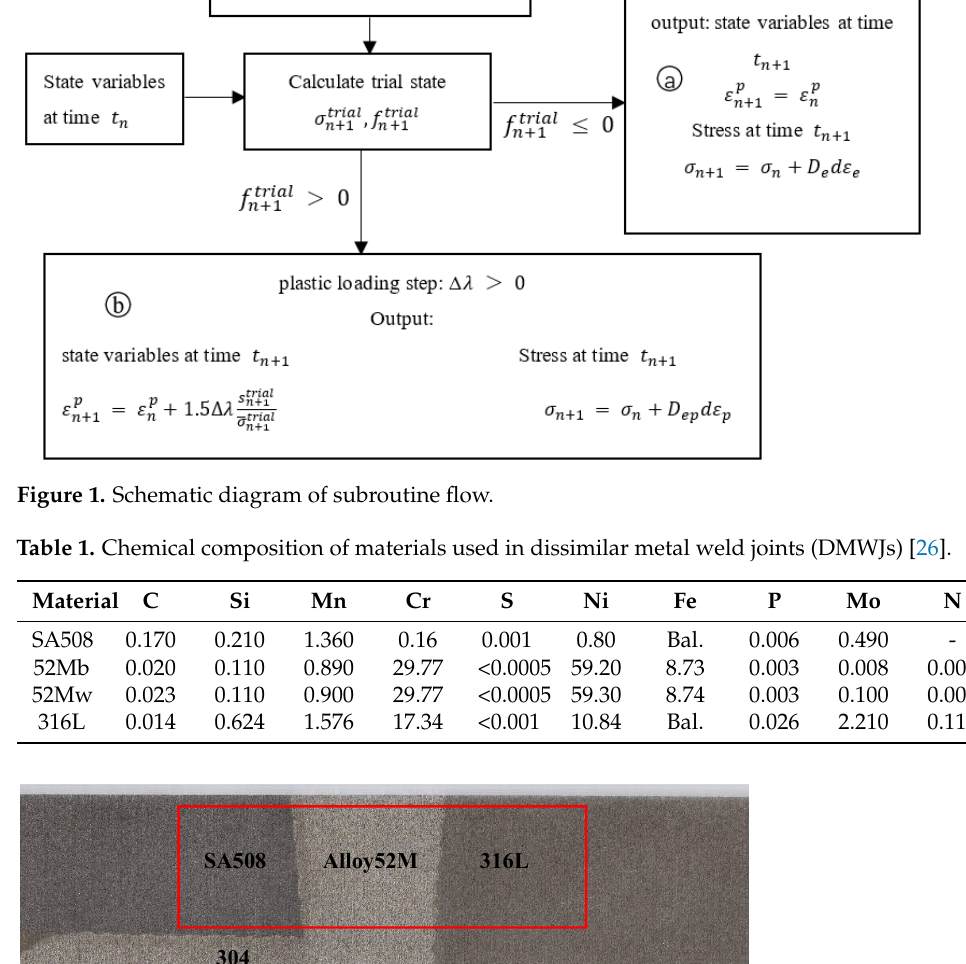
Figure 1. Schematic diagram of subroutine flow.